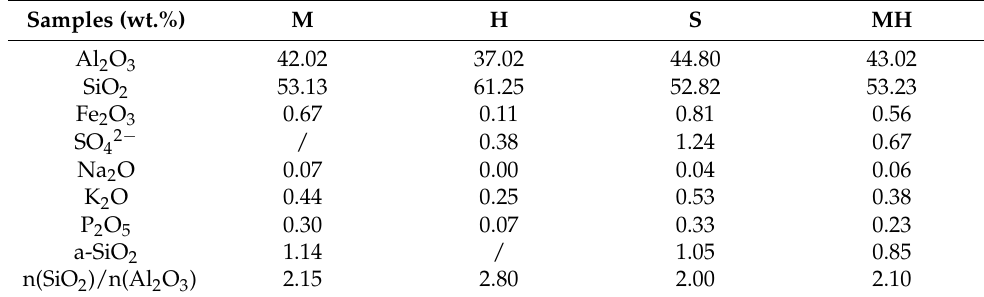
Table 1. Chemical composition of kaolin.